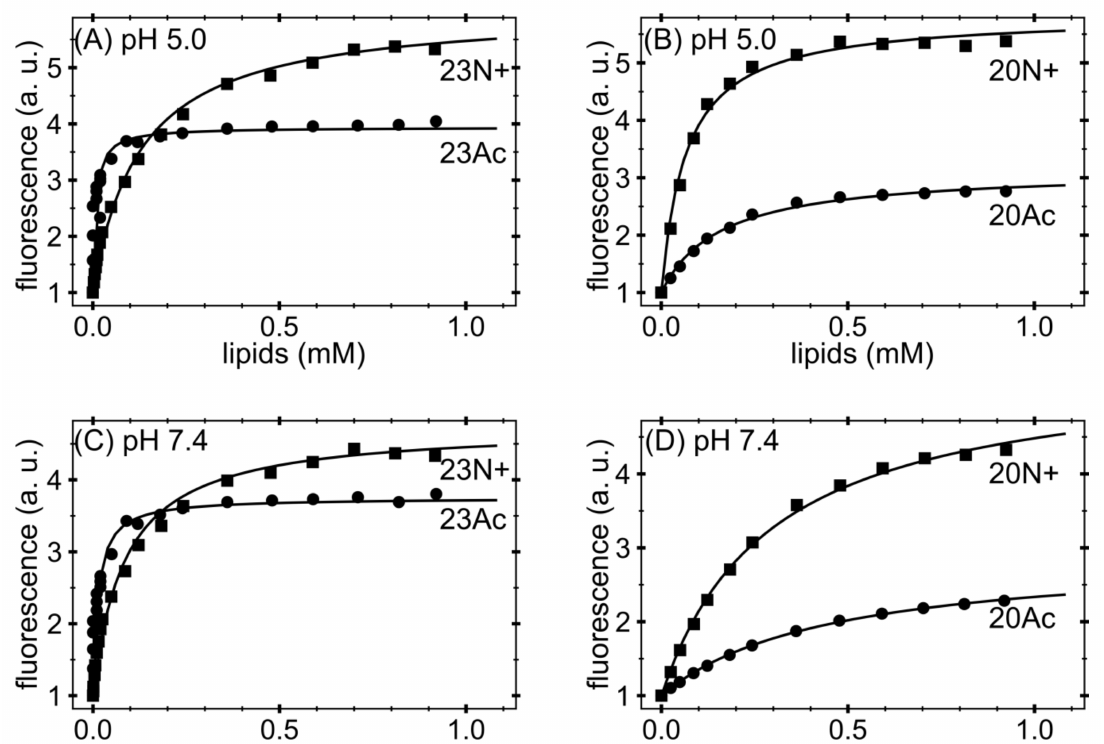
Figure 2. Binding curves obtained from native tryptophan fluorescence and titration with large unilamellar vesicles (LUV). Stronger binding of acetylated fusion peptides to phosphocholine (PC) small unilamellar vesicles analyzed by native peptide fluorescence at: ( A , B ) acidic pH; and ( C , D ) neutral pH. a.u.—arbitrary